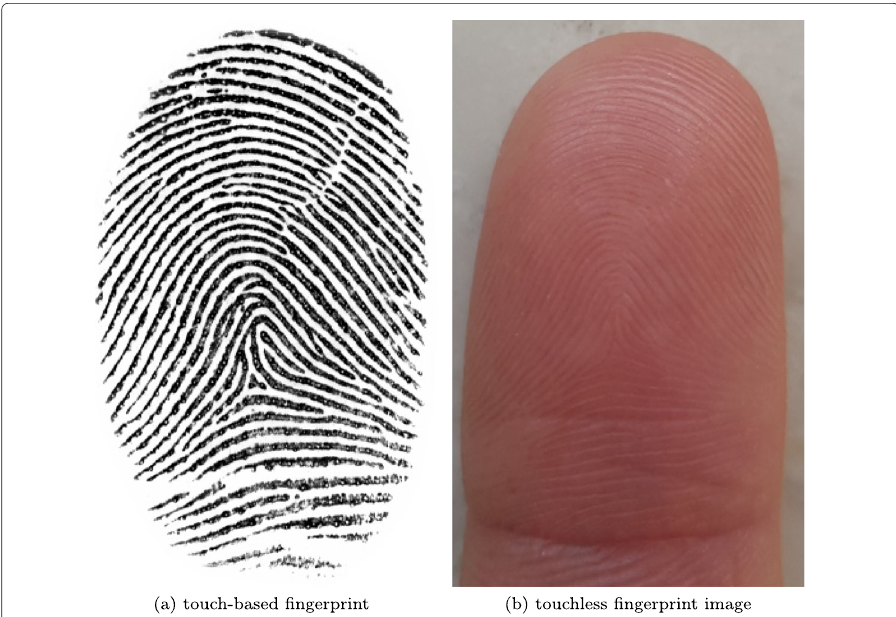
The National Institute of Standards and Technology (NIST) [13] published a guidance document for the evaluation of touchless fingerprint capturing. The document accurately defines requirements for the assembly of touchless fingerprint capturing devices with respect to different application scenarios.